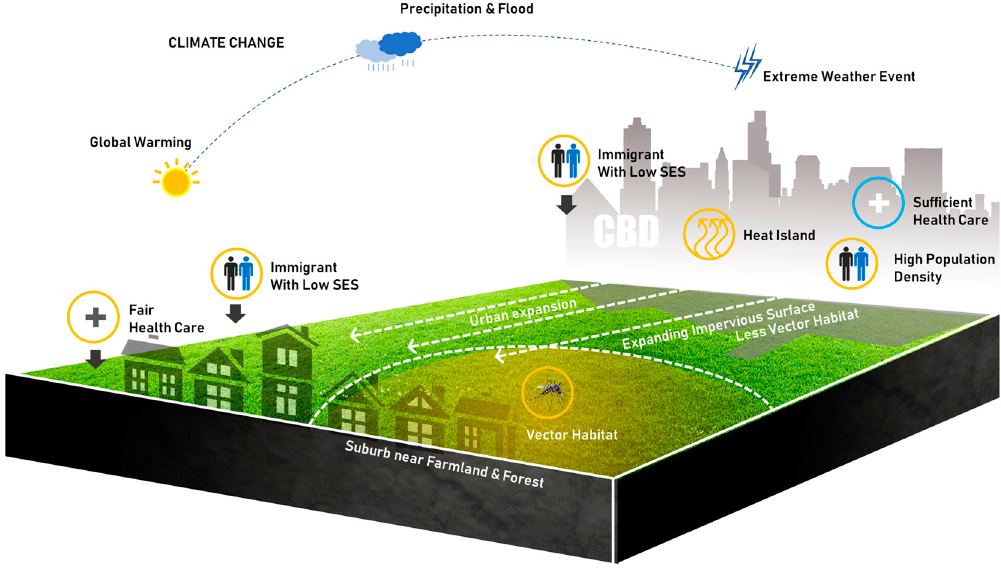
Figure 1. Urban Expansion, Epidemics, and Climate Change.